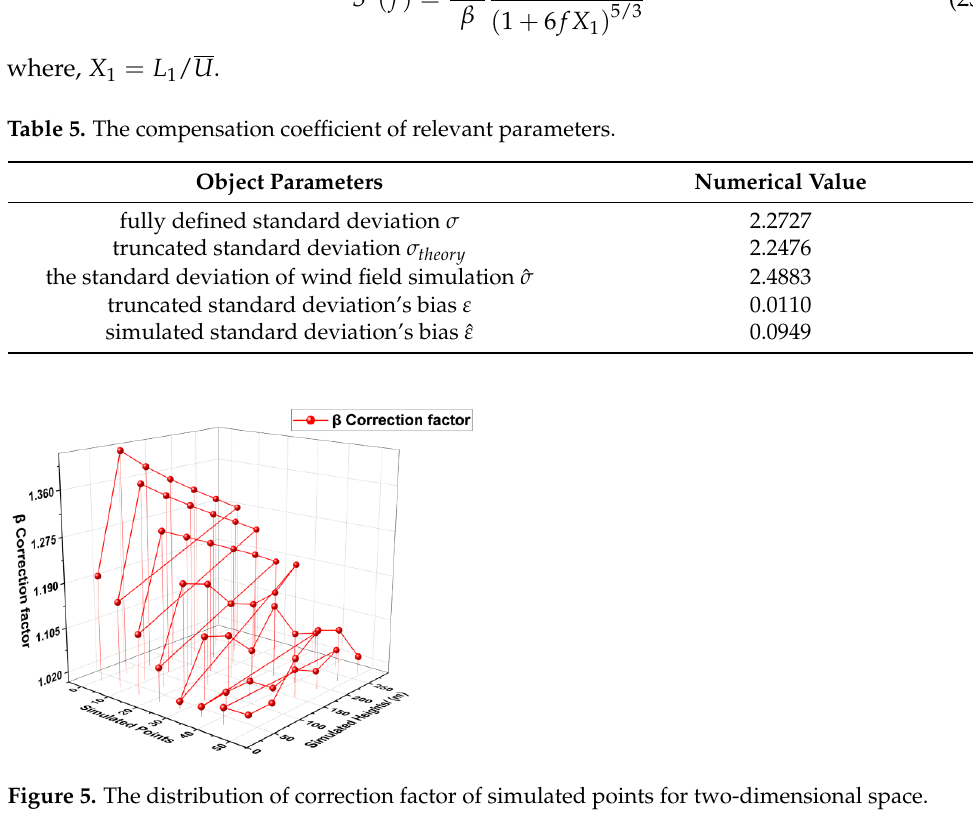
Table 5. The compensation coefficient of relevant parameters.